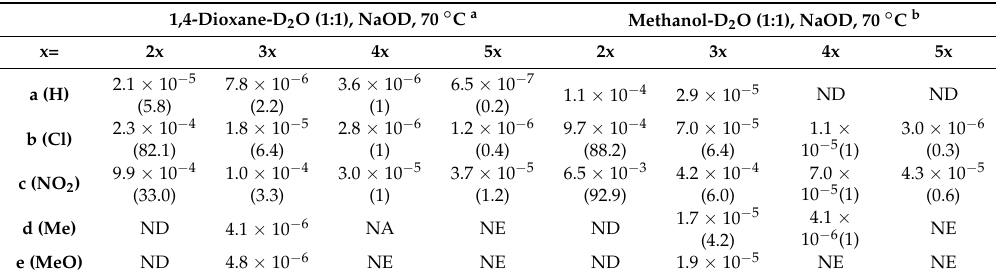
Table 3. Base-catalyzed hydrolysis rates ( − k obs in M − 1 s − 1 ) of amides 2x – 5x ( x = a – e ) in two solvent systems. a Average values are shown where possible (see footnotes). Relative reaction rates (referenced to 4 ) are shown in parentheses.